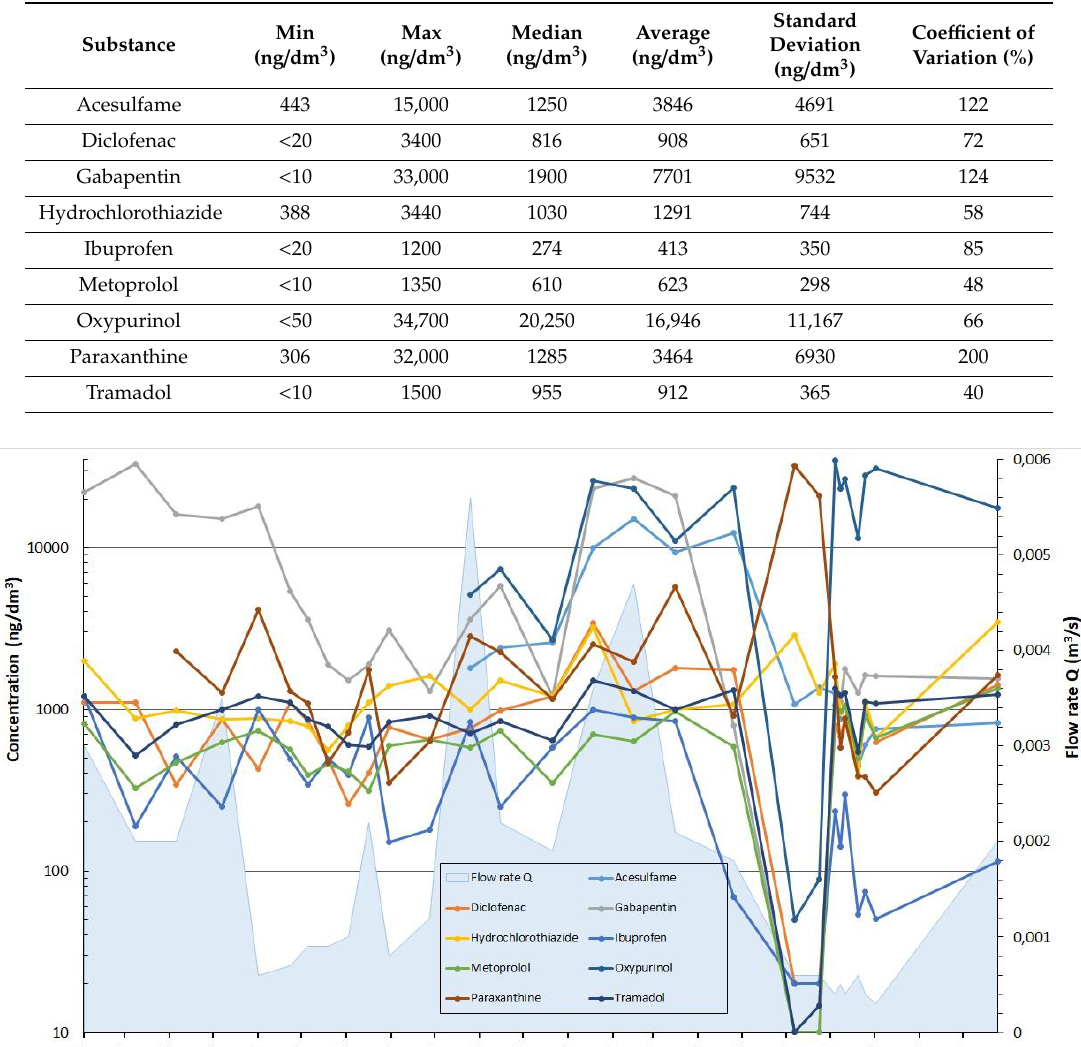
Table 4. Hnevkovice Profile—basic statistical parameters.